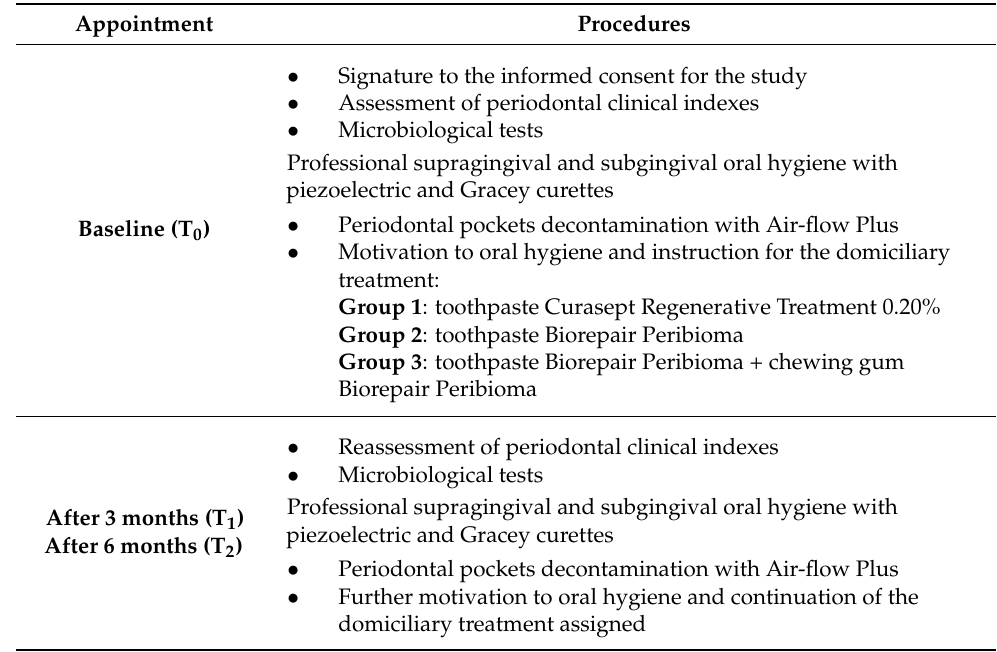
Table 2. Protocol of the